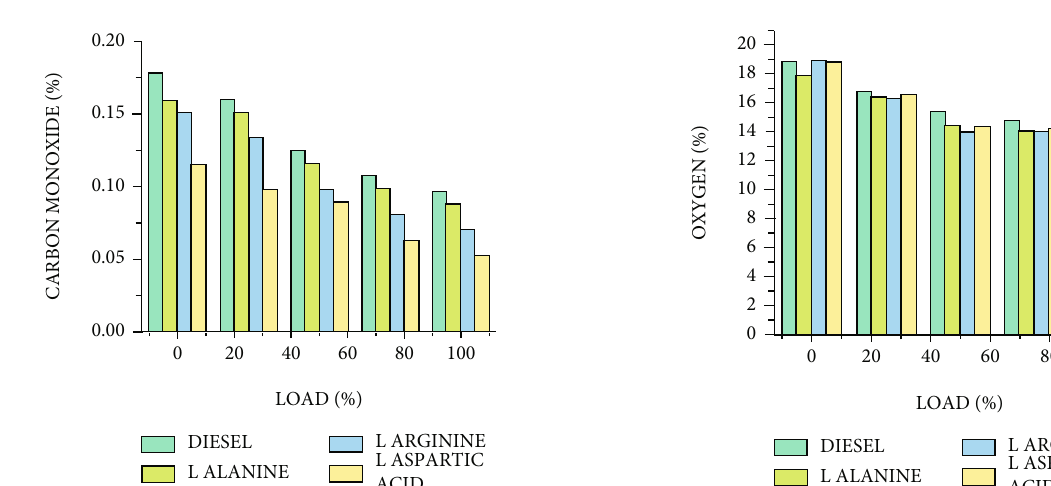
concentration with respect to engine 2